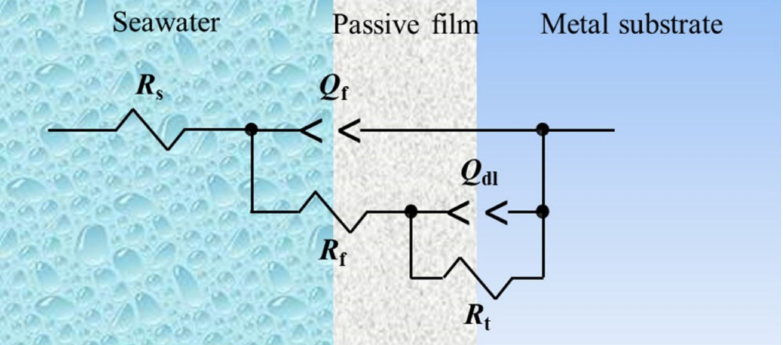
Figure 16. Equivalent circuit used to fit the electrochemical impedance